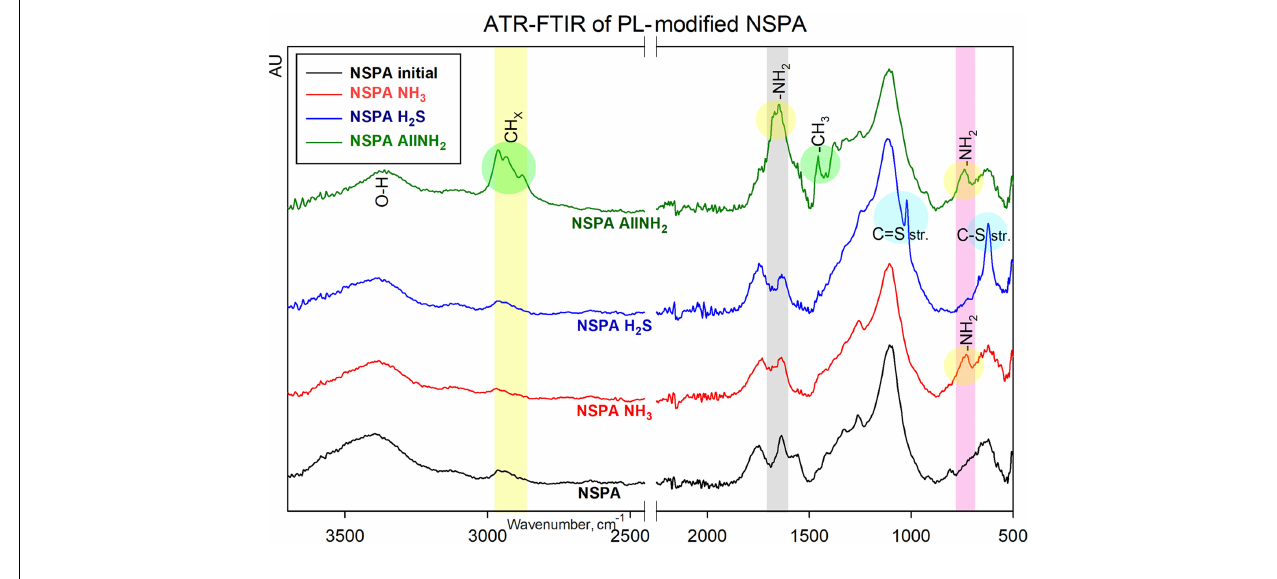
FIGURE 5 | ATR-FTIR spectra of PL-modified NSPA type of DND.